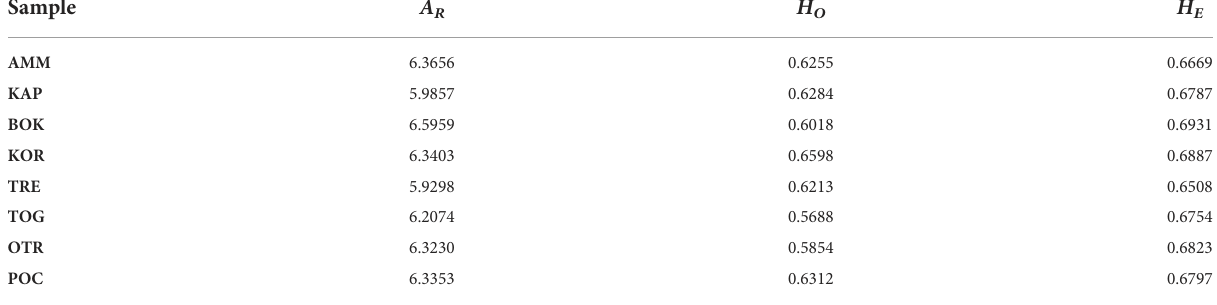
TABLE 3 Summary of genetic variability estimates across sampling locations averaged over all 14 microsatellite loci.